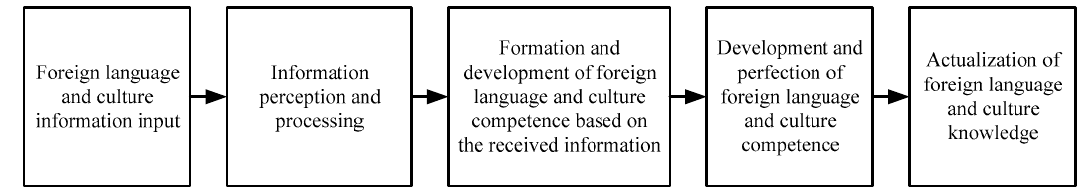
Figure 3. The general scheme of stages of work with video information at realization of audiovisual technologies for foreign language training.